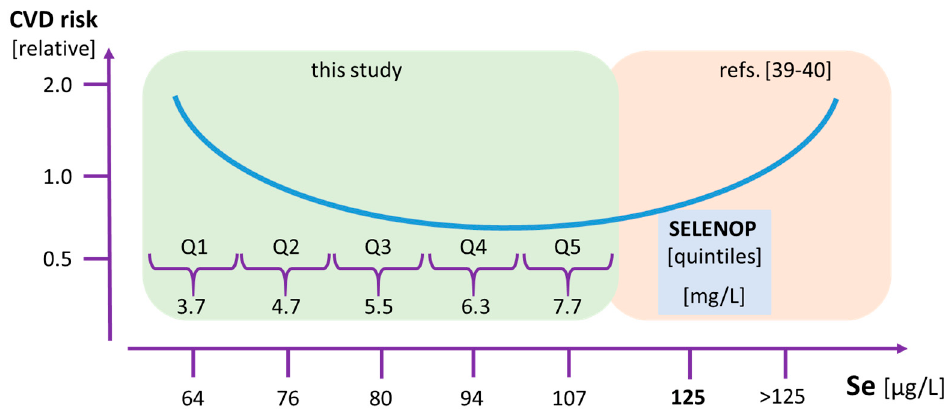
Figure 3. Presumed U-shaped interaction of Se status and CVD risk. The present study indicates a highly increased risk for cardiovascular endpoints in subjects residing in the lowest quintile (Q1) of SELENOP status as compared to the other subjects with higher SELENOP status (Q2–Q5). The figure presents both the plasma SELENOP and corresponding total Se concentrations. The green shaded area denotes the results from the current study, whereas the red shaded part presents an extrapolation of published studies from areas with higher baseline selenium status.